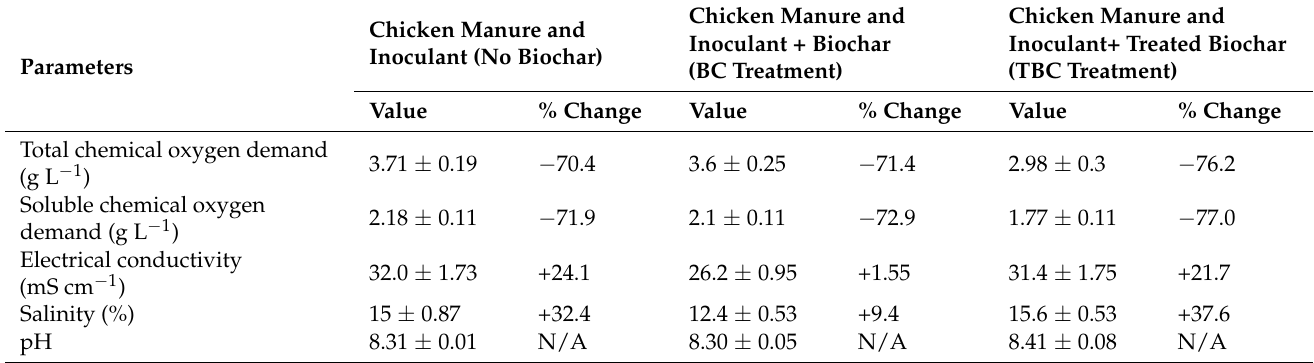
Table 3. Properties of day 110 digestates and percentage changes relative to day 0